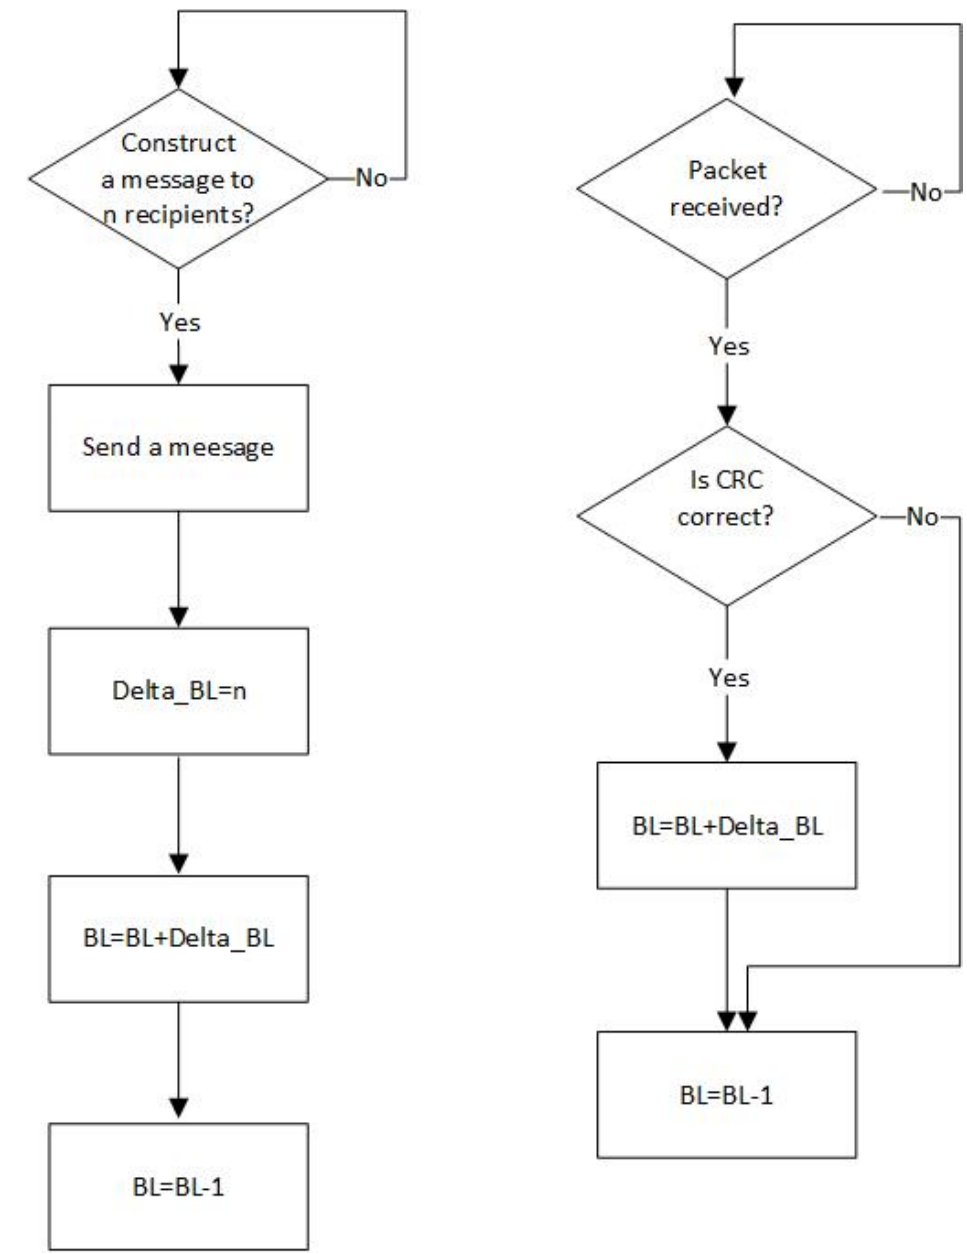
Figure 1. Backlog counting algorithm for transmitting nodes ( left diagram), and for receiving nodes ( right diagram) if the nodes are not equipped with collision detection.